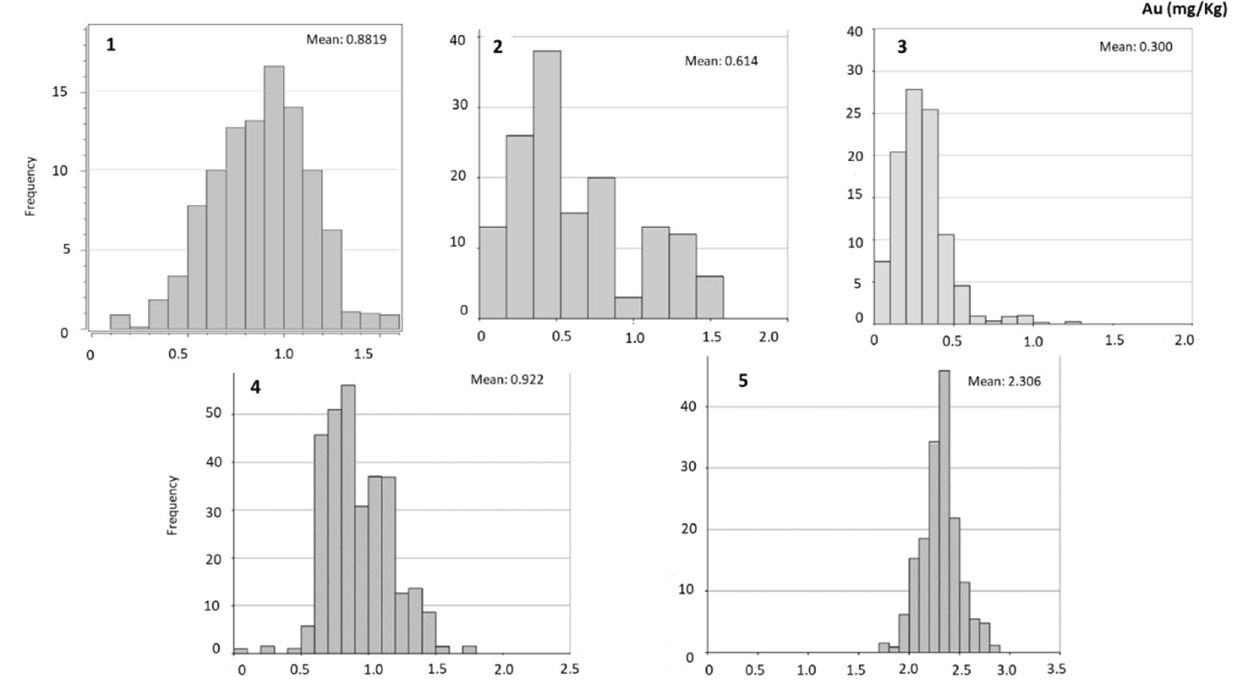
Figure 7. Distribution of Au contents in the block from 3D model for deposits 1 to 5.